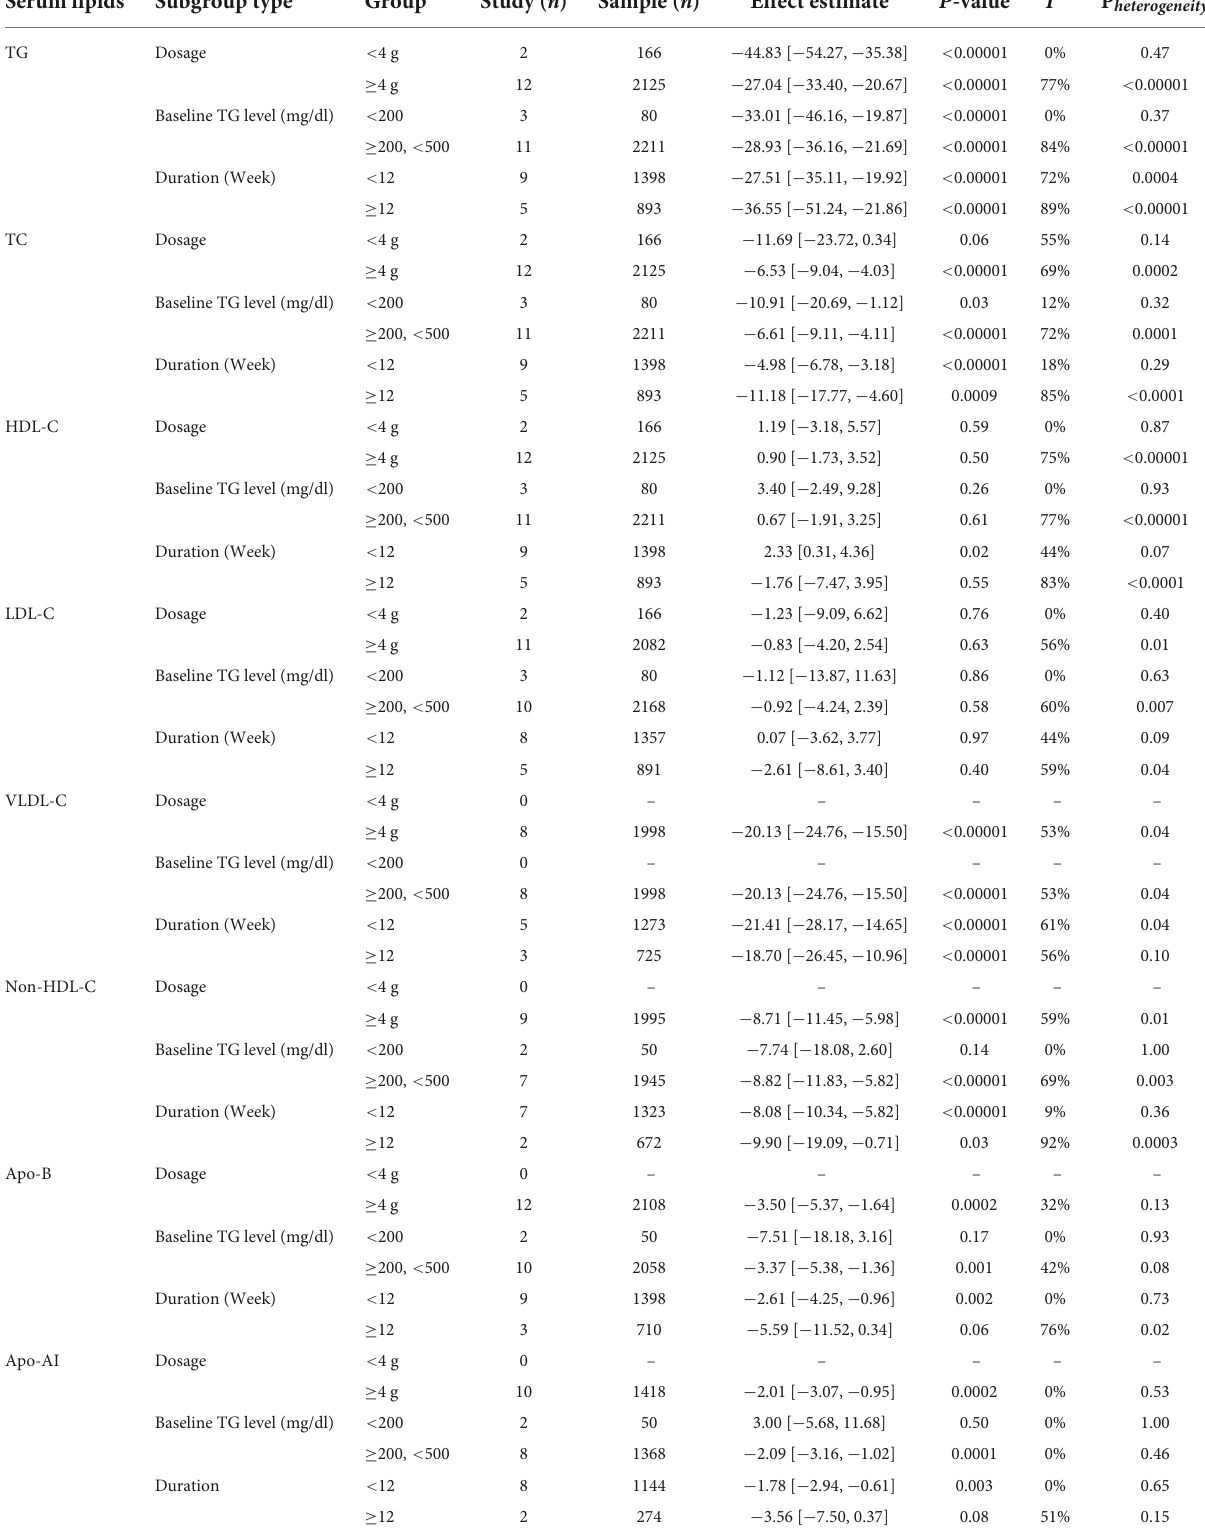
TABLE 3 Subgroup analysis of the effect of combined therapy of statins plus OM3-FA on lipid profile. Serum